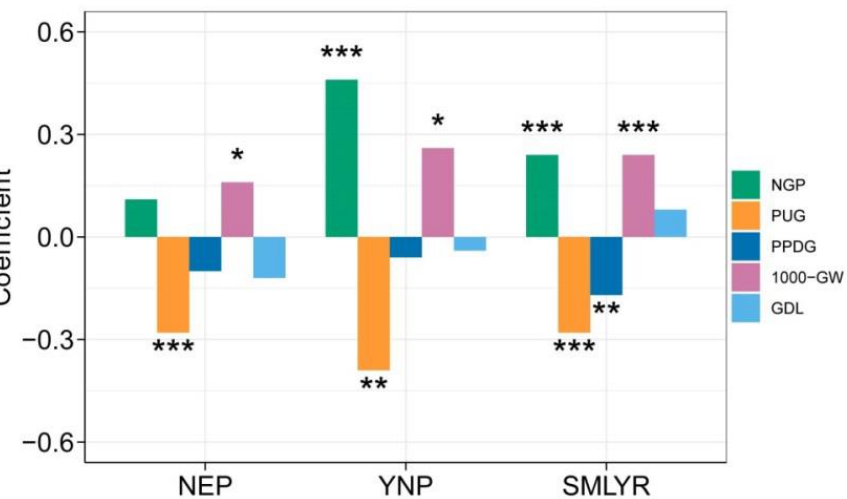
Figure 6. Correlations between rice yield with yield-related variables. Correlations significant at the 0.05 level are marked by *, while those significant at the 0.01 level are marked by ** and those significant at the 0.001 level by ***. NGP, number of grains per panicle; PUG, percentage of undeveloped grain; PPDG, percentage of partially developed grain; 1000-GW, 1000-grain weight; GDL, growth duration length during the heading and flowering